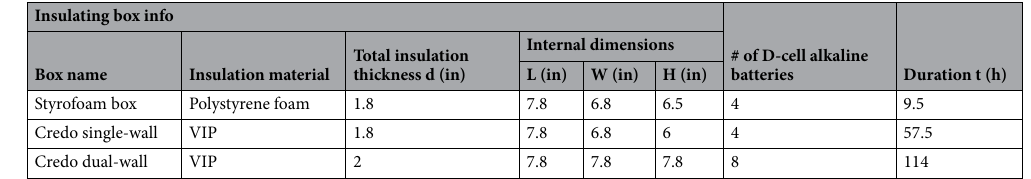
Table 3. Duration of µCRAIT box working at fridge temperature (4 °C) for three box